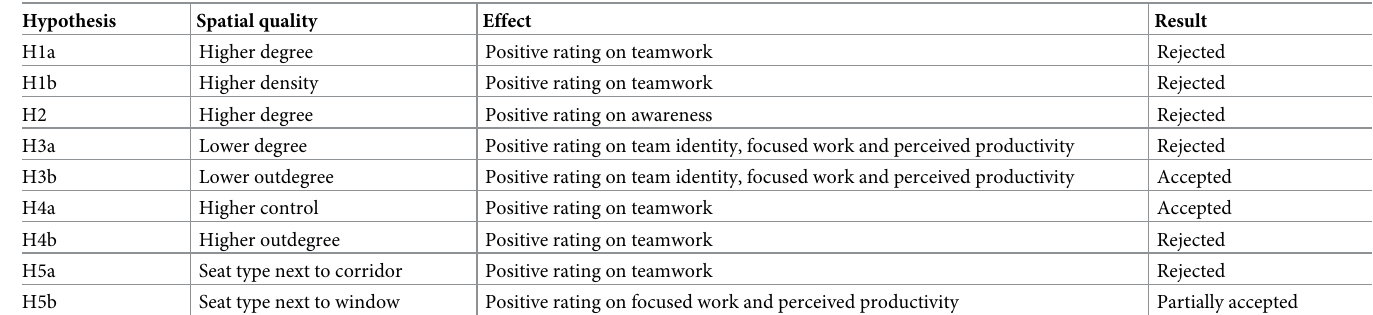
Table 4. Summary of supported and rejected